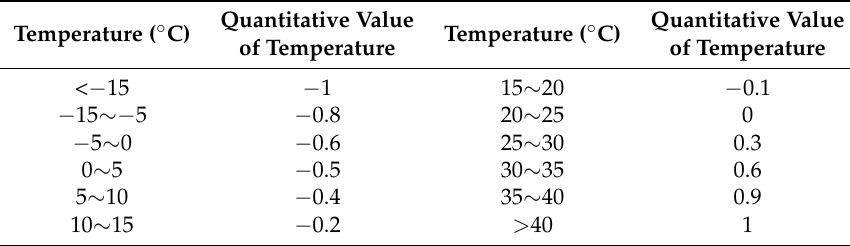
Table 7. Quantitative value of temperature.